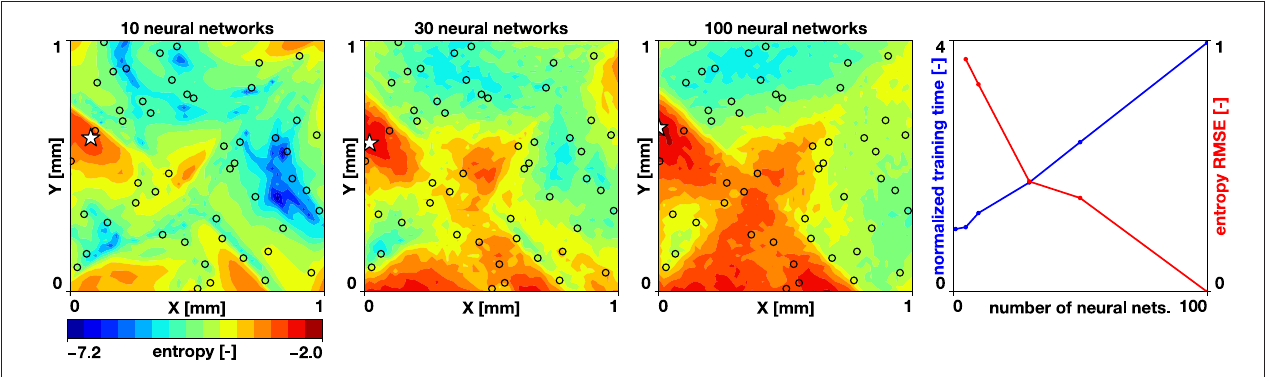
FIGURE 4 | Uncertainty quantification and effect of number of neural networks. Entropy predicted by 10, 30, and 100 neural networks, and the tradeoff between entropy reduction and normalized training time for increasing number of neural networks. The black circles indicate the sampling